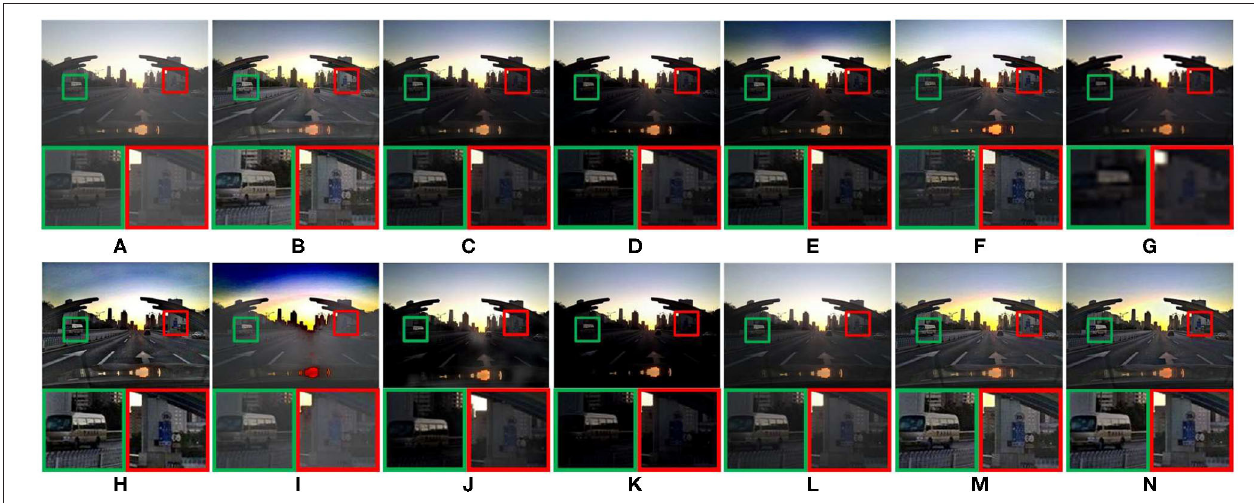
FIGURE 7 | Synthetic driving image. (A) represents the original foggy image. (B–N) Represent foggy-free images processed by AMEF, CAP, CO, DCP, DEFADE, GPR, MAMF, OTE, WCD, DehazeNet, FFA-Net, MIF, and the proposed method.